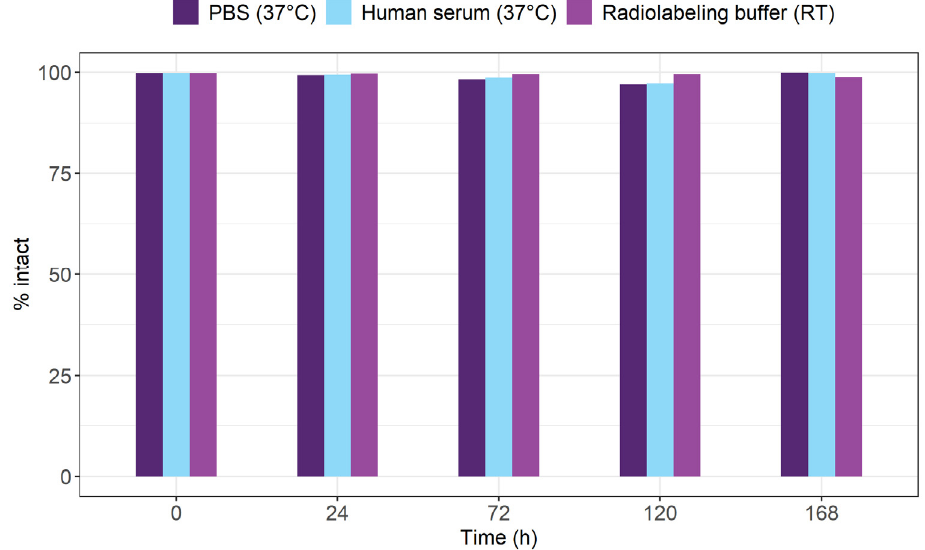
Figure 1. [ 153 Sm]Sm-DOTA-TATE did not show any leaching of 153 Sm from the chelator in PBS at 37 °C, human serum at 37 °C and radiolabeling buffer at RT for at least 7 days. RT = room temperature.